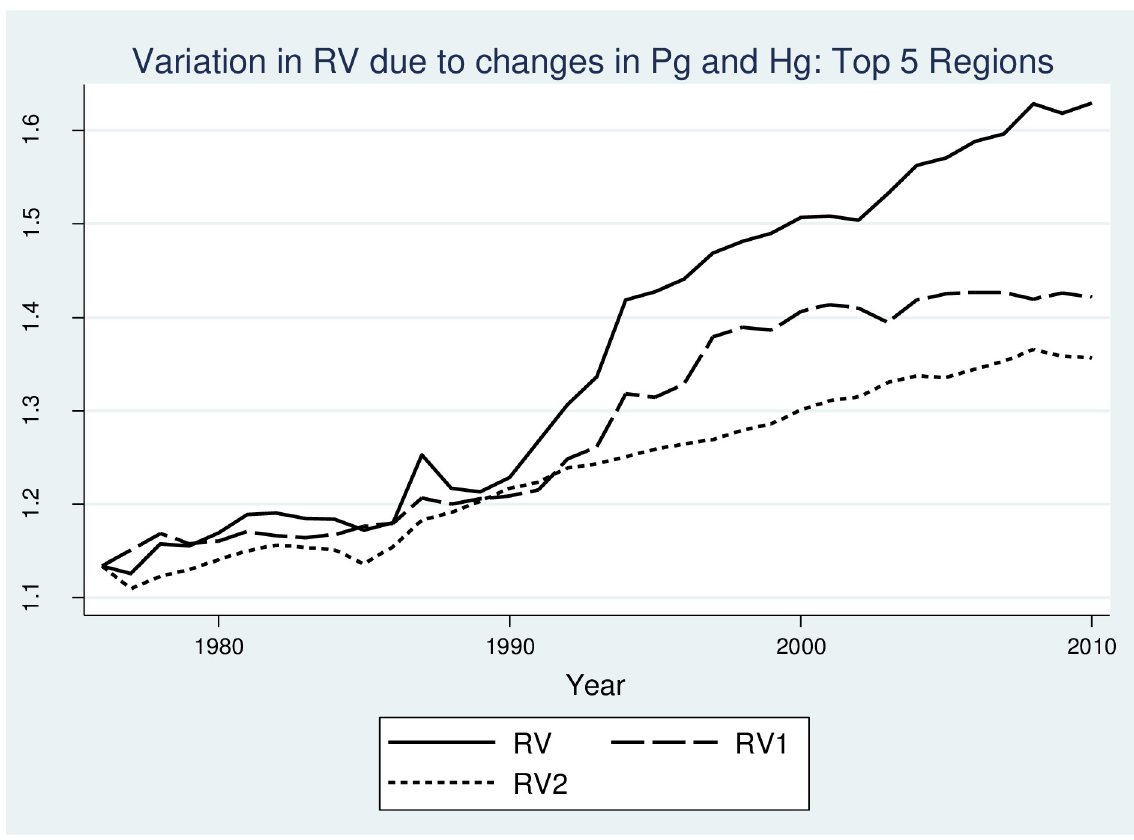
Fig 8. Relative importance of Pg and Hg in the growth of RV over time: Top 5 regions. Notes: RV1: Related variety measured by keeping Pg constant at the values at 1976. RV2: Related variety measured by keeping Hg constant at the values at 1976.